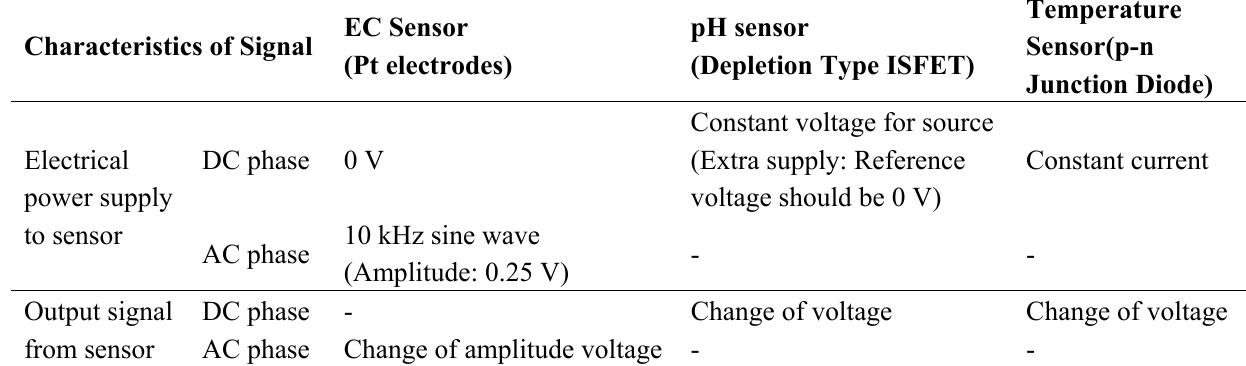
Table 1. Operating conditions for pH, EC and temperature sensing